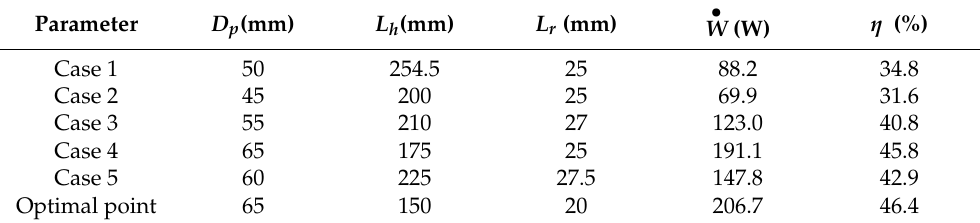
Table 6. Given guesses and optimal points.